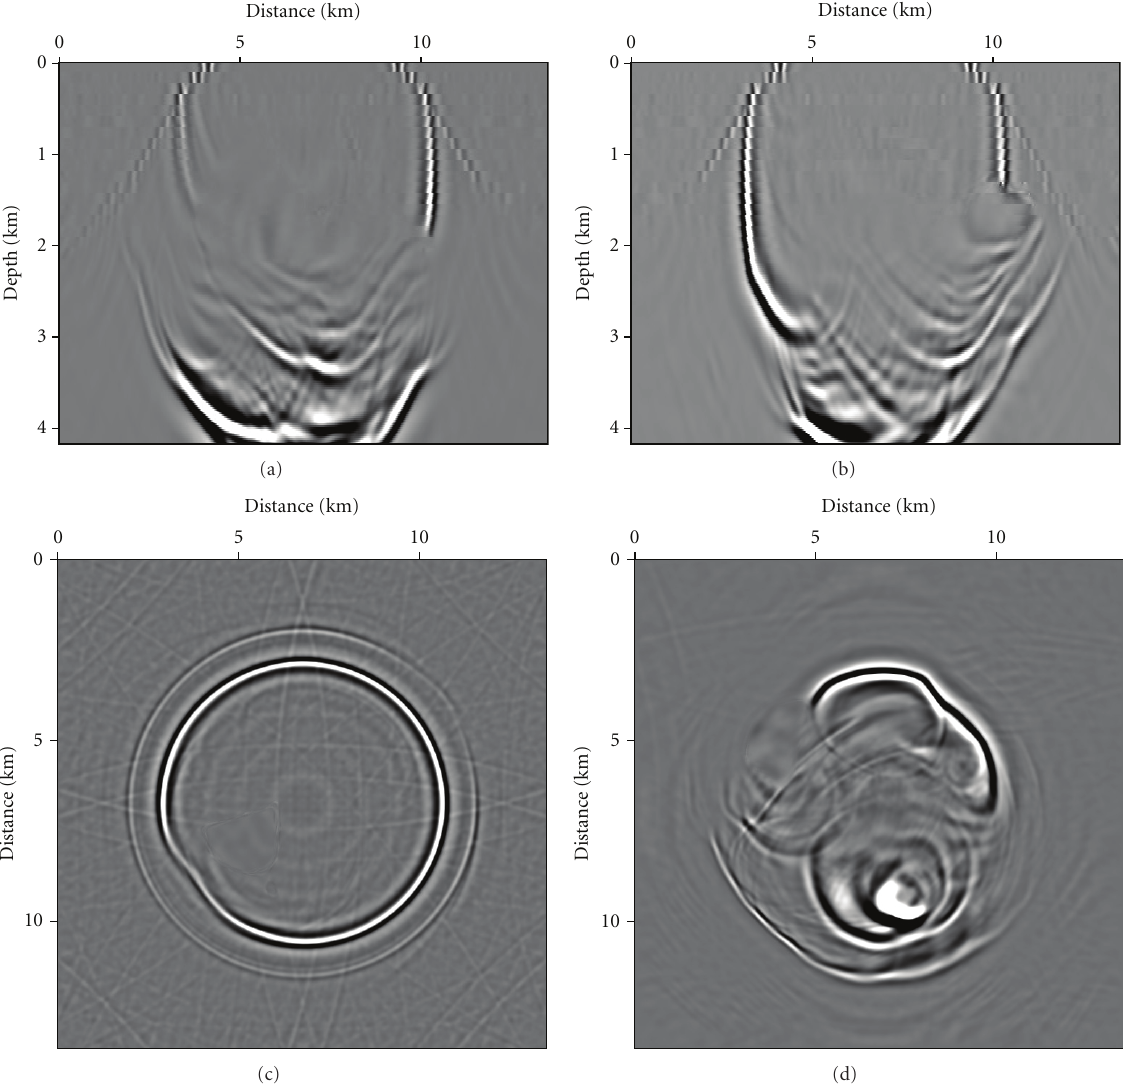
Figure 8: Impulse response obtained by FD migration using the real Pad´e approximation with 3 terms and Li correction (cross-sections as